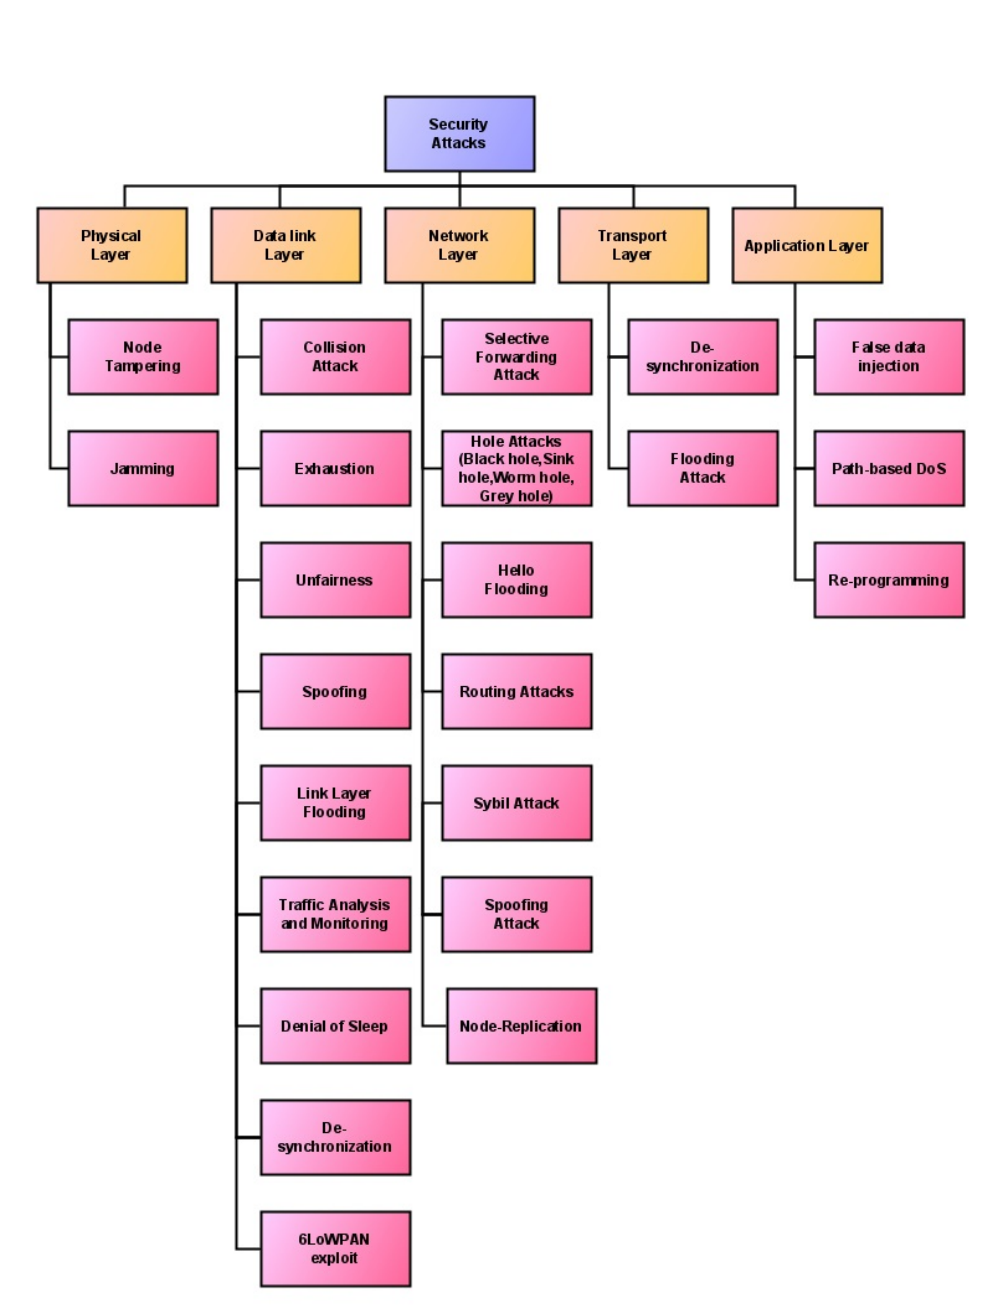
Figure 3. Security attacks on WSN integrated to